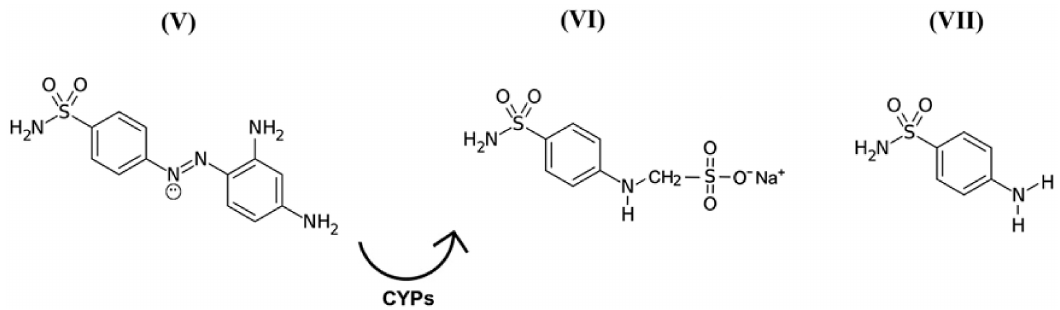
Figure 3. Structural and molecular formulas of historically first forms of sulfanilamide